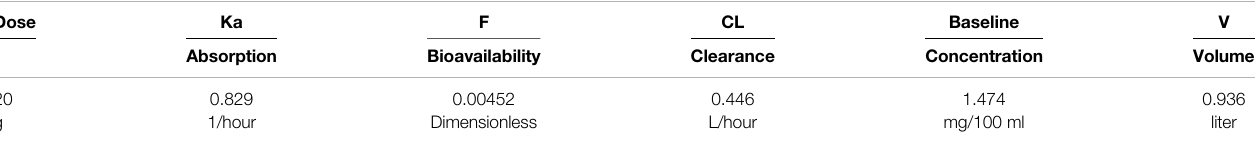
TABLE 3 | Naive pooled fi tted parameters for the poorly conditioned model shown in Figures 2A,B .